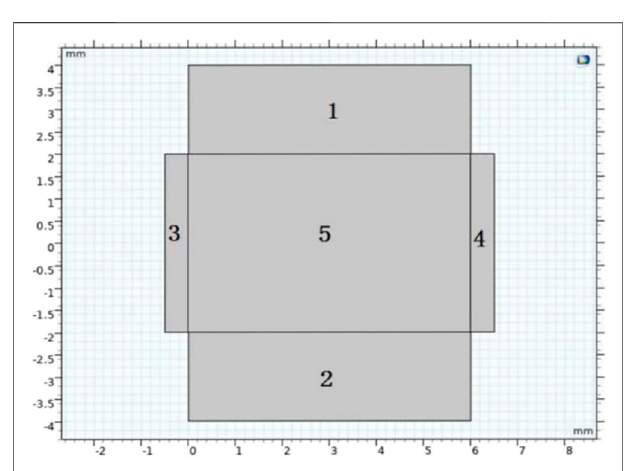
FIGURE 5 | Model of interaction of discharged neon and THz